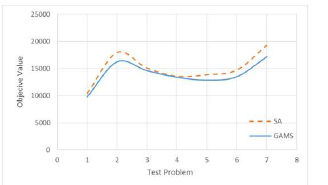
Fig. 7. Objective value for P 1 to P 7 (SA and GAMS)